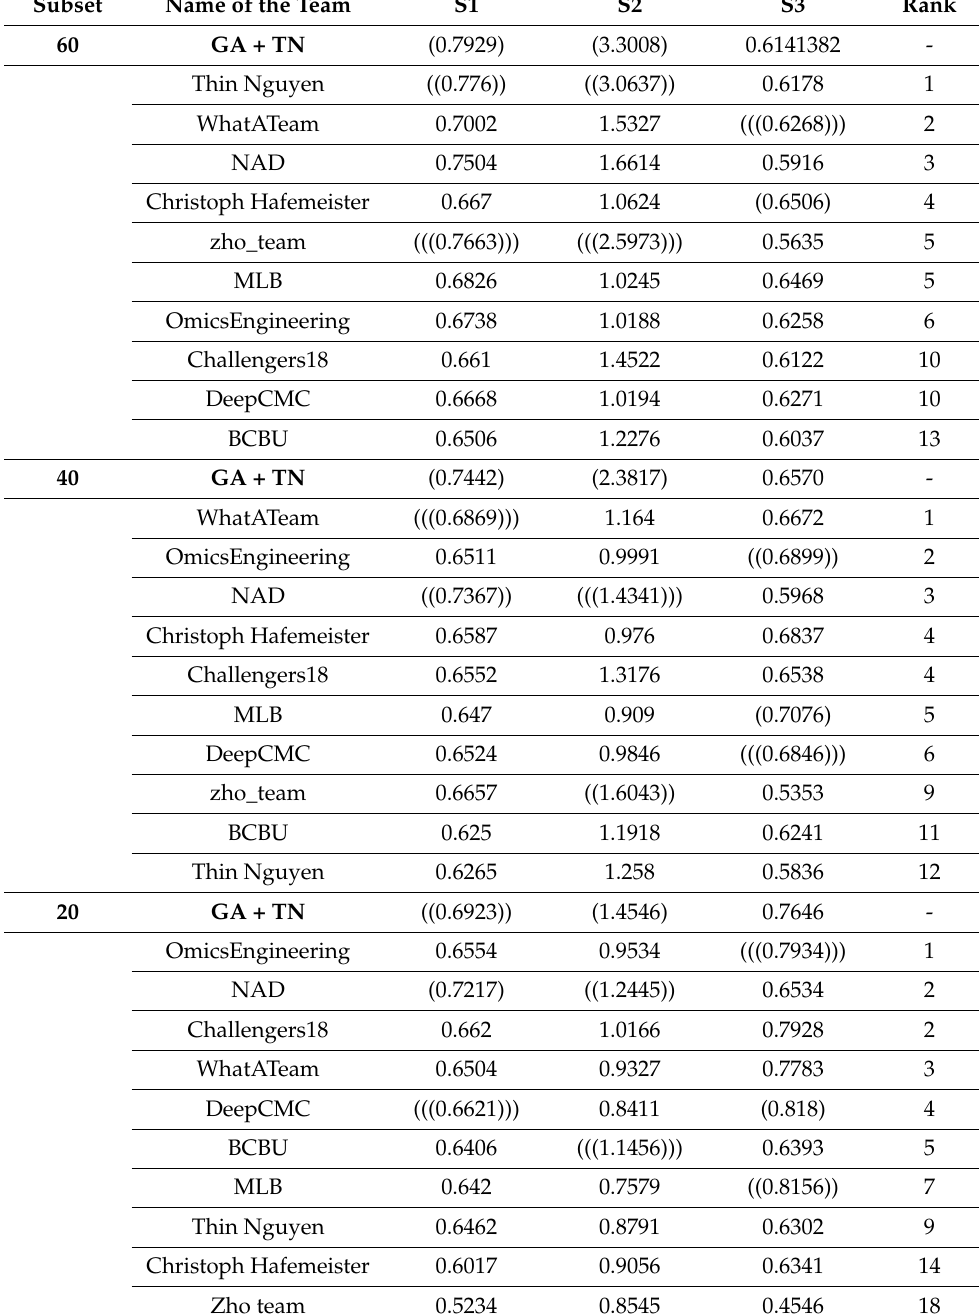
Cells highlighted in single, double and triple brackets represent the top three ranks within each challenge, respectively. Source for Thin Nguyen (TN) team’s prediction method (Sub-challenge 1) is available from https: